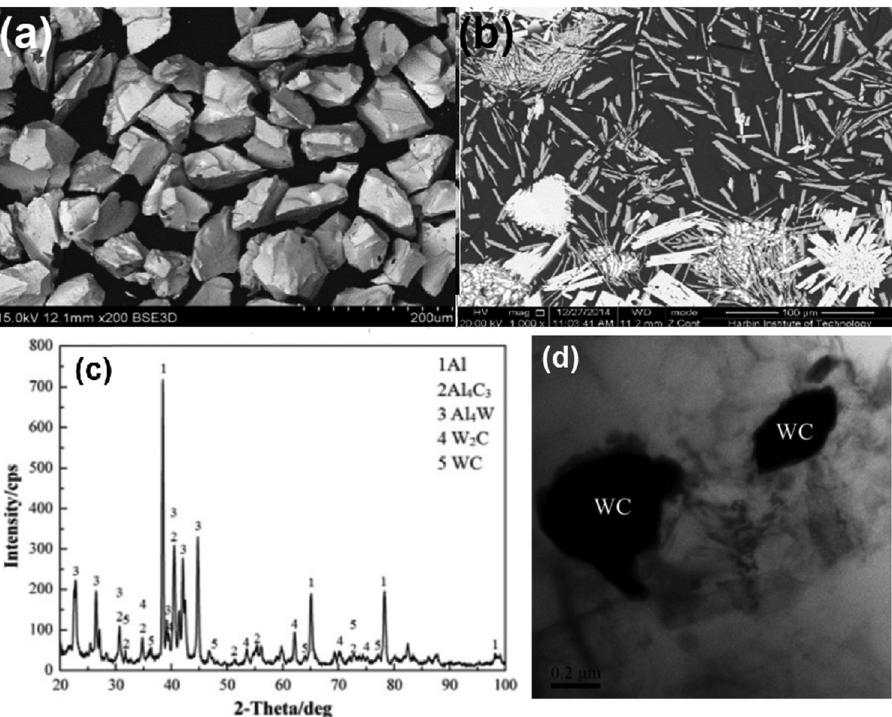
Figure 7: SEM images of ( a ) WC particles used as reinforcement and ( b ) the composite obtained after adding the WC particles to a 6061 Al alloy ( 0.8 – 1.2 Mg, 0.40 – 0.8 Si, 0.7max.Fe, 0.15 – 0.40 Cu ) , using laser welding. ( c ) XRD di ff ractogram of the obtained WC/Al composite. ( Reproduced with permission from [ 123 ] . ) ( d ) TEM image of an Al/3vol%WC composite ( Reproduced with permission from [ 128 ] . )